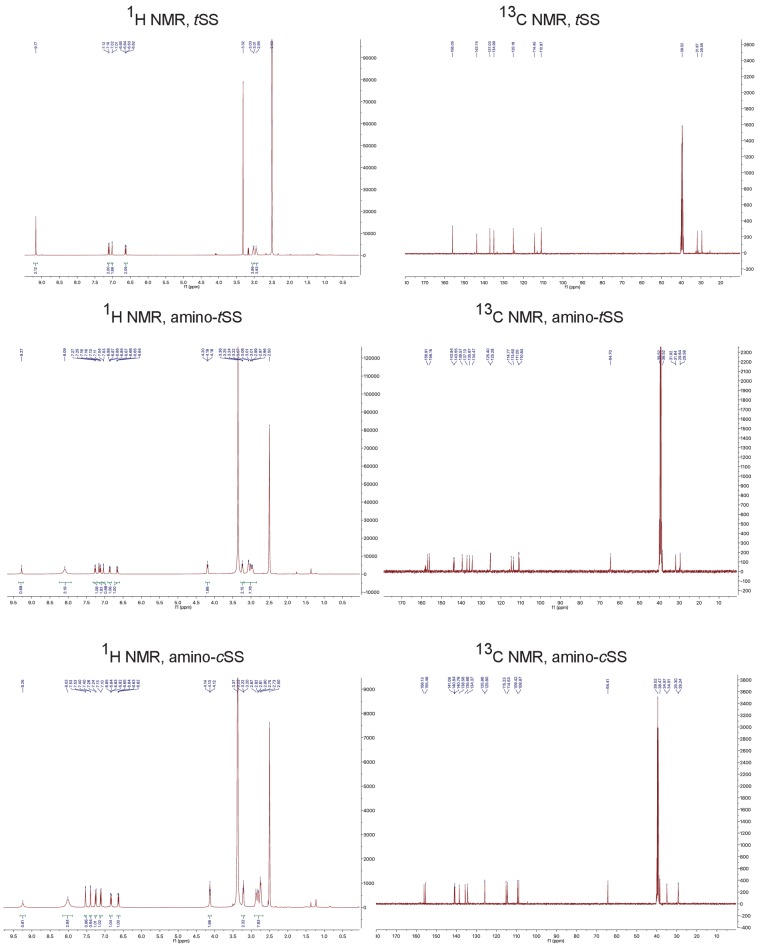
1H and 13H NMR spectra of tSS, amino-tSS, and amino-cSS.